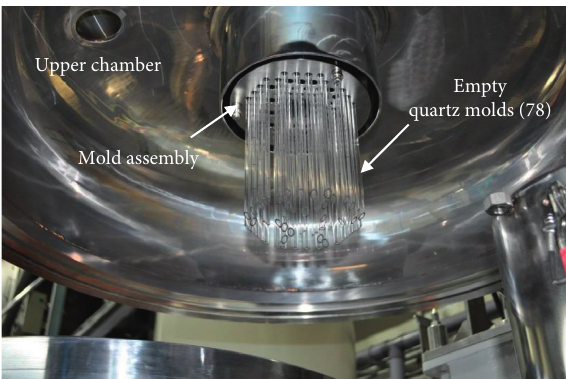
Figure 9: Mold assembly with 78 empty quartz molds loaded into center of interior bottom side of the upper